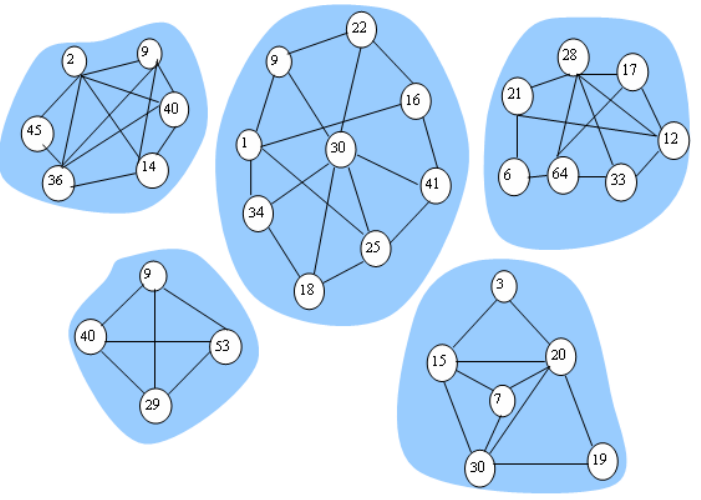
Figure 2. Community